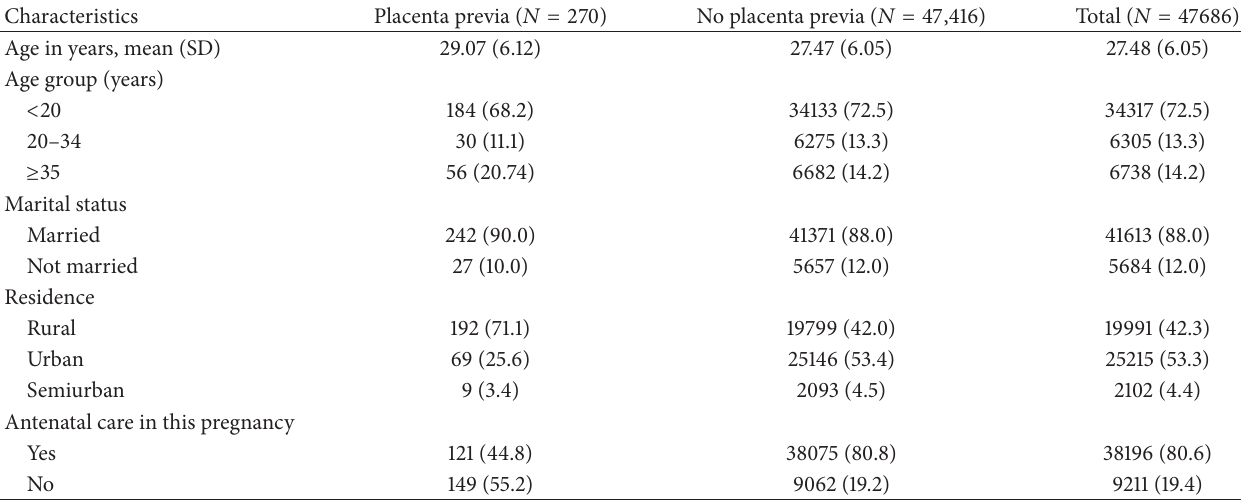
Table 1: Background characteristics of women participating in the study in Northern Tanzania ( 𝑁 = 47